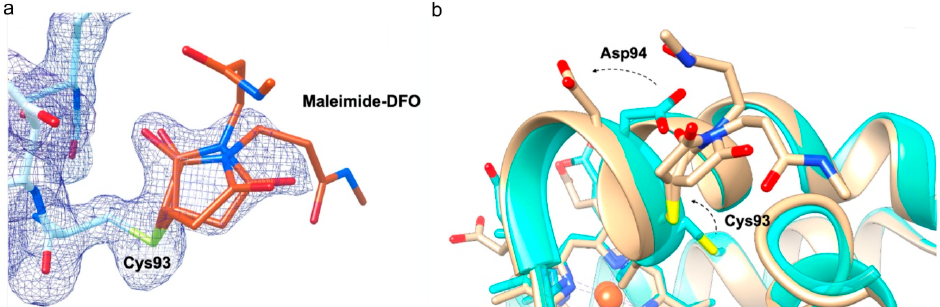
Figure 1. Local conformational changes observed for Cys93 and Asp94 upon reaction with maleimide-DFO in β chains. ( a ) Close up view on β 1 Cys93 covalently bound to maleimide-DFO. The electron density map of the maleimide ring bound to Cys93 is shown and contoured at 1 σ . In both β chains the maleimide ring and the first six atoms of DFO were identified in double conformations, 50% occupancy of the first six atoms of DFO and high B-factors do not allow electron density to be visible when contoured at 1 σ . Carbon atoms are shown in orange for DFO, in white for Hb; nitrogen atoms are in blue, oxygen in red, sulfur in yellow ( b ) Secondary structure superposition of the native aquomet-Hb structure (transparent turquoise, PDB 3P5Q) with the Hb-DFO structure (opaque tan). The covalent bond between Cys93 and the maleimide-DFO induces a re-orientation of the side chains of Cys93 and Asp94, without a ff ecting the main chain and the helical geometry of the F helix. Both residues move in the same direction, minimizing steric hindrance and exposing DFO to the solvent environment.